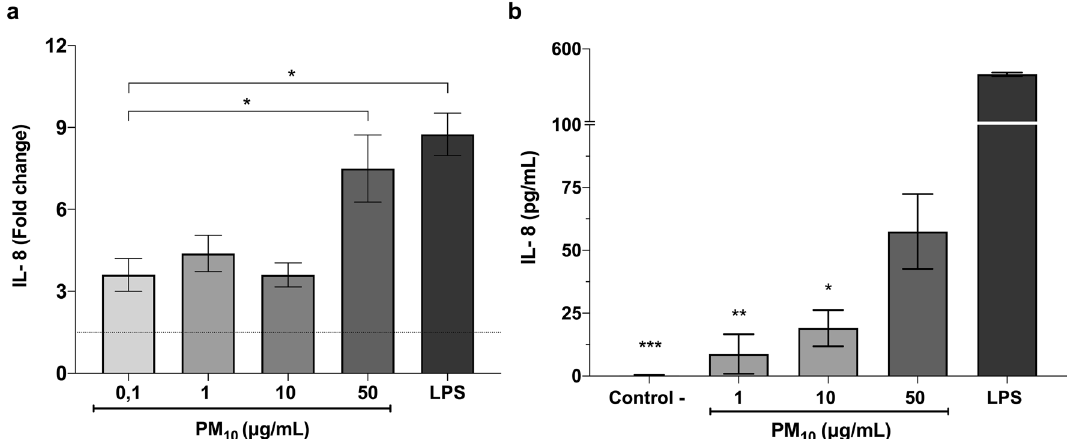
Figure 2. PM 10 exposure induces IL-8 in PMNs. ( a ) IL-8 mRNA expression and ( b ) IL-8 release in PMNs exposed to different concentrations of PM 10 (0.1, 1, 10 and 50 µg/mL) for 5 h. Negative control (culture medium); positive control (LPS). The dotted line illustrates the 1.5-fold increase over the untreated negative control. All data are represented by the mean ± SEM of 8 healthy donors. * p < 0.05; **p < 0.01; ***p < 0.001, by Kruskal–Wallis analysis with post hoc Dunn’s test. In ( b ), the asterisk represents differences compared with the LPS stimulated cells.